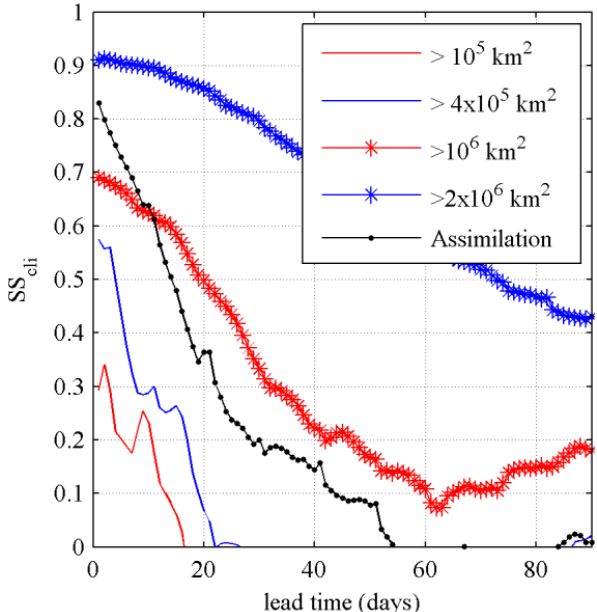
Figure 10. Median skill score SS of stream flow forecasts at gauging stations as function of 2 Fig. 10. Median skill score SS cli of stream flow forecasts at gauging cli stations as function of lead time. Different curves show results con- sidering gauges with different drainage areas (red and blue lines) lead time. Different curves show results considering gauges with different drainage areas (red 3 and only gauges used for data assimilation (black line with and blue lines) and only gauges used for data assimilation (black line with dots). 4